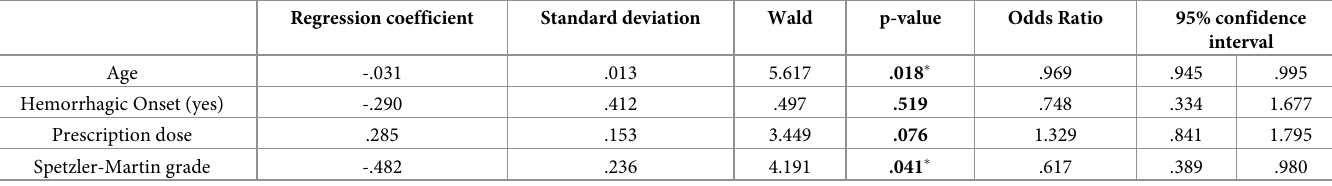
Table 3. Influence of age, hemorrhagic onset, prescription dose and Spetzler-Martin score on obliteration.